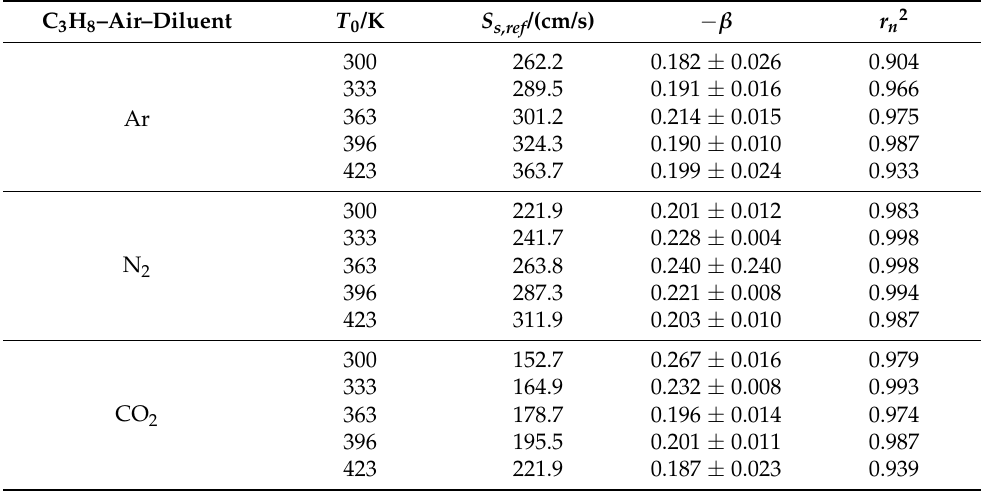
Table 2. Reference PVs (experimental data) and their baric coefficients, β , for stoichiometric C 3 H 8 – air–10% diluent mixtures ( Ss,ref at p 0 = 1 bar).